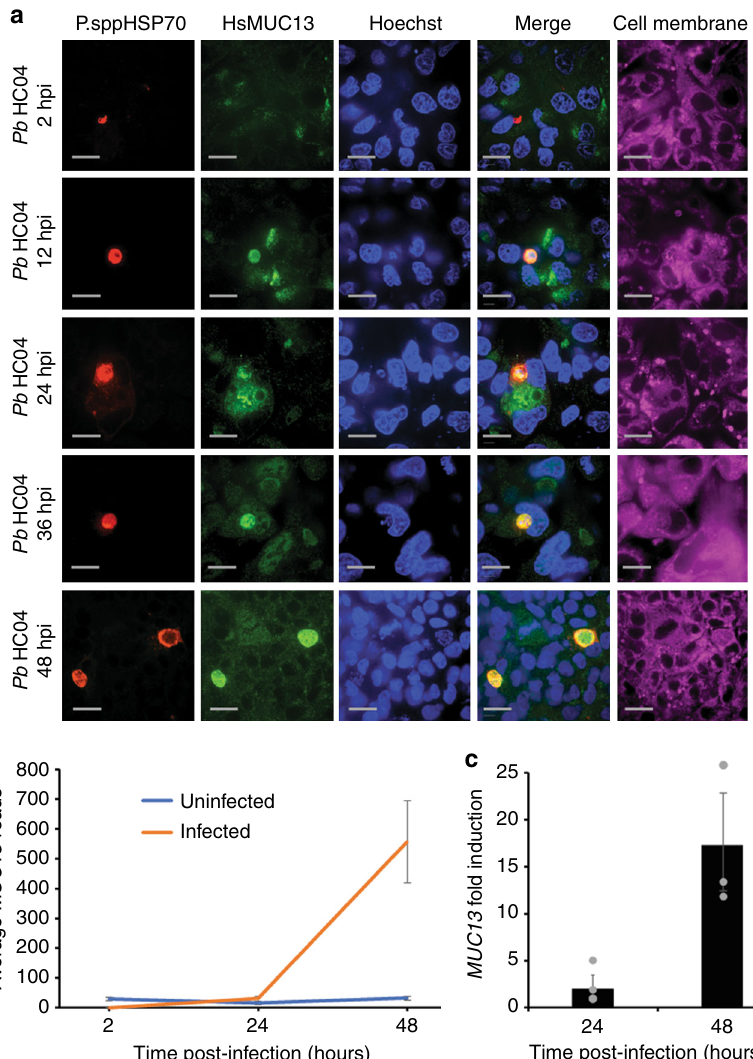
Fig. 3 Temporal detection of MUC13 in HC04 cells infected with P. berghei . a HC04 cells were infected with P. berghei sporozoites and then fi xed and stained at 2, 12, 24, 36, and 48 hpi. Infected cell cultures were stained using a 1:500 dilution (1 mg/ml stock) of mouse polyclonal antibody to P.spp HSP70 (see methods) and a 1:500 dilution of rabbit polyclonal antibody to MUC13 intracellular domain (MUC13 antibody #2 — LifeSpan BioSciences #C345092). Primary antibody localization was visualized with goat anti-mouse (Alexa Fluor 647, red) and goat anti-rabbit (Alexa Fluor 488, green) secondary antibodies, respectively. Nuclei were stained with Hoechst 33342 (blue) and cell membranes with CellMask deep red (magenta). Scale bars 10 μ m; 60× oil objective. b The total reads, from the Huh7.5.1 RNA seq samples 1 – 3, for MUC13 at the 5 indicated time points (0 h uninfected, 24 h infected, 24 h uninfected, 48 h infected, and 48 h uninfected). c The fold-induction of MUC13 , based upon the total read count in panel B, at 24 and 48 hpi, presented as a ratio of Infected:Uninfected. Data presented as mean ± s.e.m, n = 3 with individual biological replicates